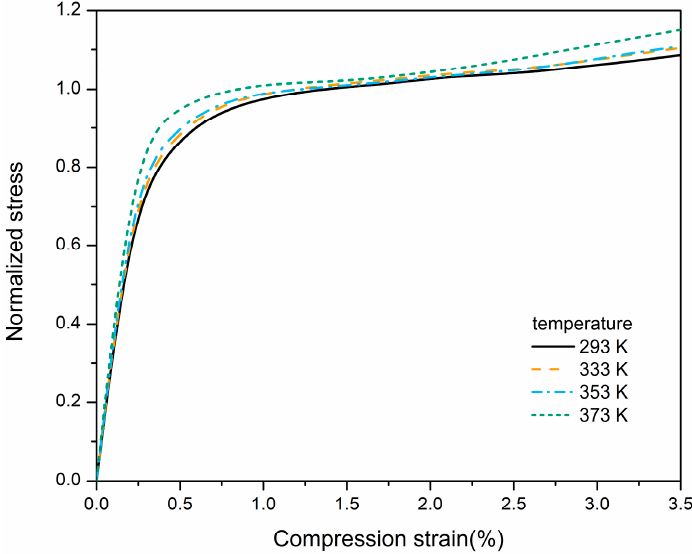
Figure 5. Stress-strain curves of PBX after being stress normalized.